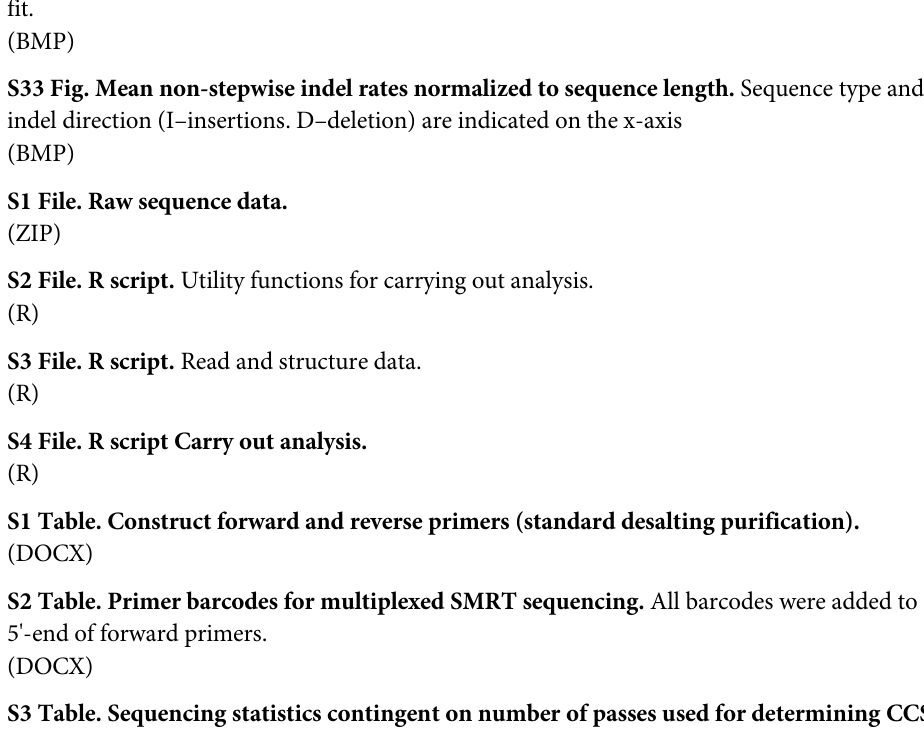
S31 Fig. Relationship between non-stepwise indel mutations and PCR regime. A-C: inser- tions. D-F: deletions. None of the relationships are statistically significant (generalized additive models). A. 30xCA: p = 0.341. B. 20xATCT: p = 0.771. C. 10xATCT: p = 0.949. D. 30xCA: p = 0.628. E. 20xATCT: p = 0.708. F. 10xATCT: p = 0.071. S32 Fig. Effect of PCR regime on indel rates in spacer regions. The y-axis shows the percent- age of total sequence reads with an indel mutation in the spacer region of the constructs. The trend line is from a linear regression model (p = 0.006). GAM modelling also indicated a linear fit. S33 Fig. Mean non-stepwise indel rates normalized to sequence length. Sequence type and indel direction (I – insertions. D – deletion) are indicated on the x-axis